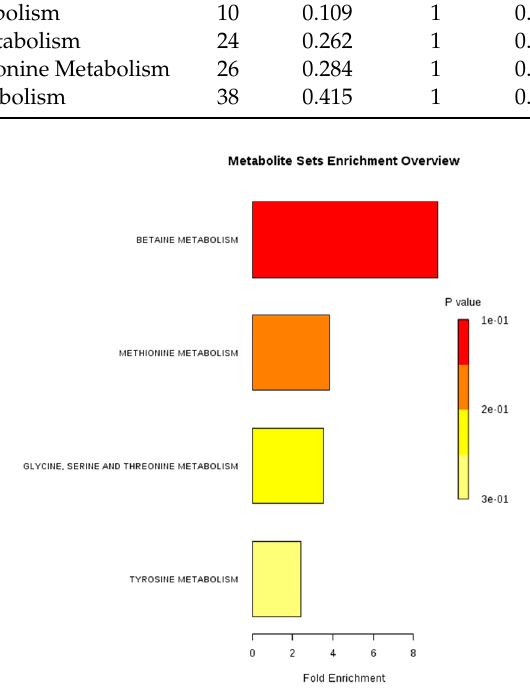
Figure 7. The e ff ect of DOP on the metabolites pathway. By uploading the nine endogenous metabolites Figure 7. The effect of DOP on the metabolites pathway. By uploading the nine endogenous to the MetaboAnalyst software, metabolite enrichment analysis could be